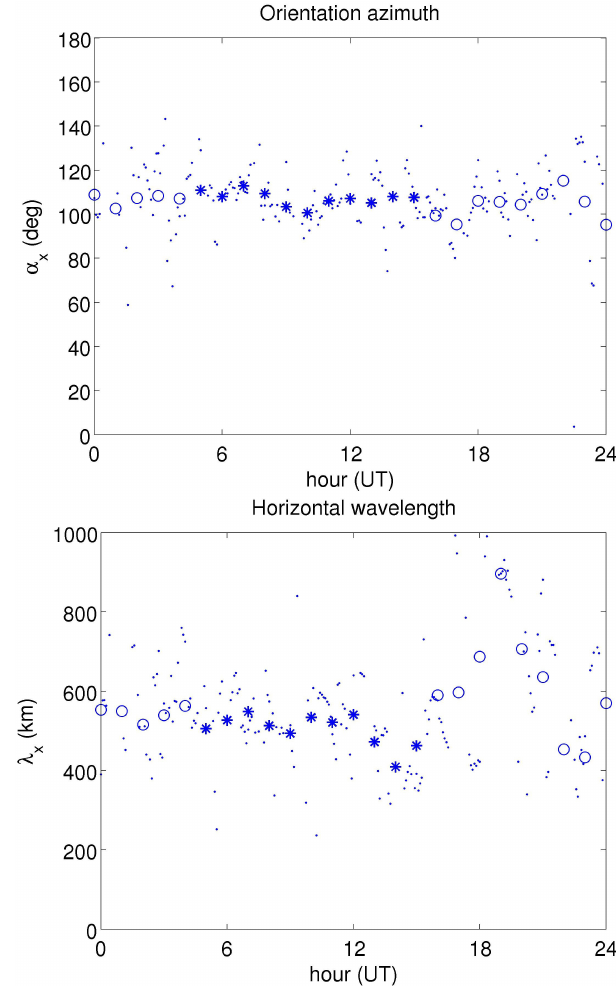
Figure 14. The horizontal orientation azimuths (upper) and the wavelengths (lower) of the spatial variations, as found from the analysis of this section. Small dots: the results for each 5min sam- ple. Stars: hourly averages. Circles: hourly averages which are con- sidered unreliable (see